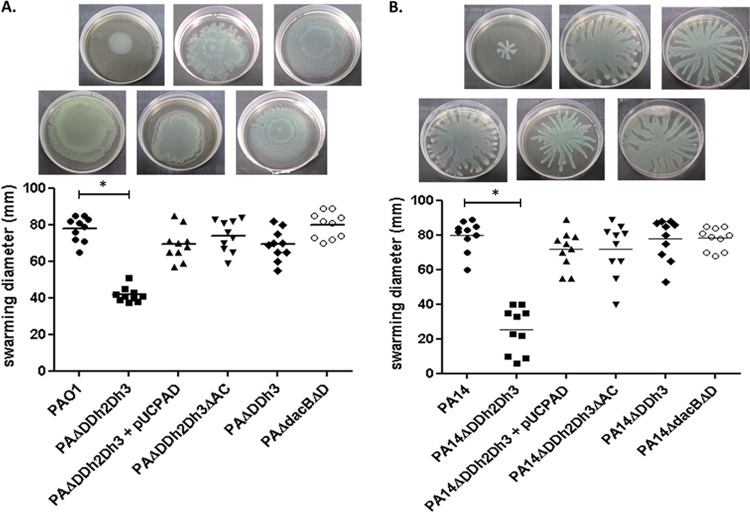
Swarming motility of strains PAO1 (A) and PA14 (B) and mutants derived from the two strains. Plates were inoculated as described in Materials and Methods. The diameters of the motility areas of 10 different colonies per strain were measured. Each symbol represents the value for one colony, and the mean value for the 10 colonies is indicated by the short black bar. The values (means) that are significantly different (P < 0.0001 by Student’s t test) from the mean value for the wild-type strain are shown by a bar and asterisk. The rest of the single and double ampD mutants of both PAO1 and PA14 showed wild-type swarming motility levels (not shown). The pictures above the graph show representative images of the corresponding strains.